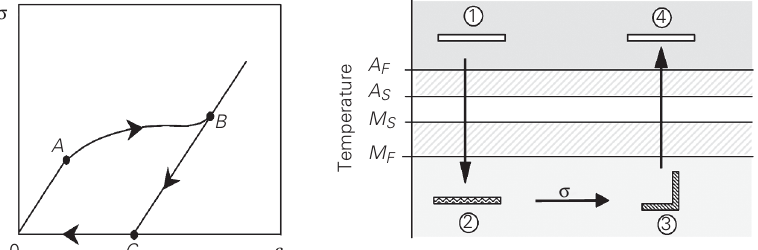
Figure 2. Shape memory effect. For abbreviations, see legend to Figure 1. See text for explanation of process.